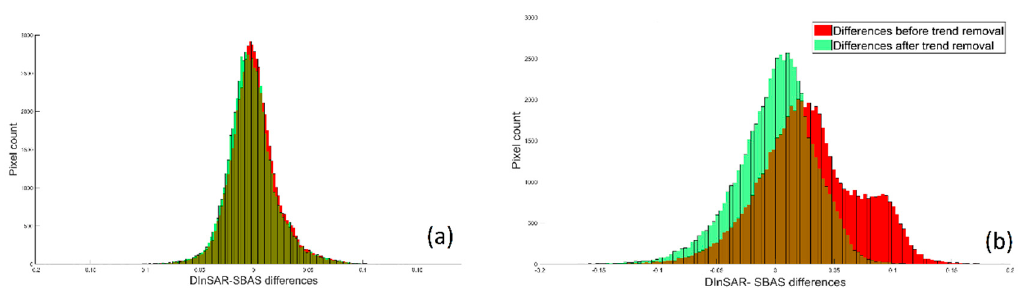
Figure 4. Histograms of differences between SBAS and DInSAR results before (red) and after (green) trend removal for ascending ( a ) and descending ( b ) orbits.